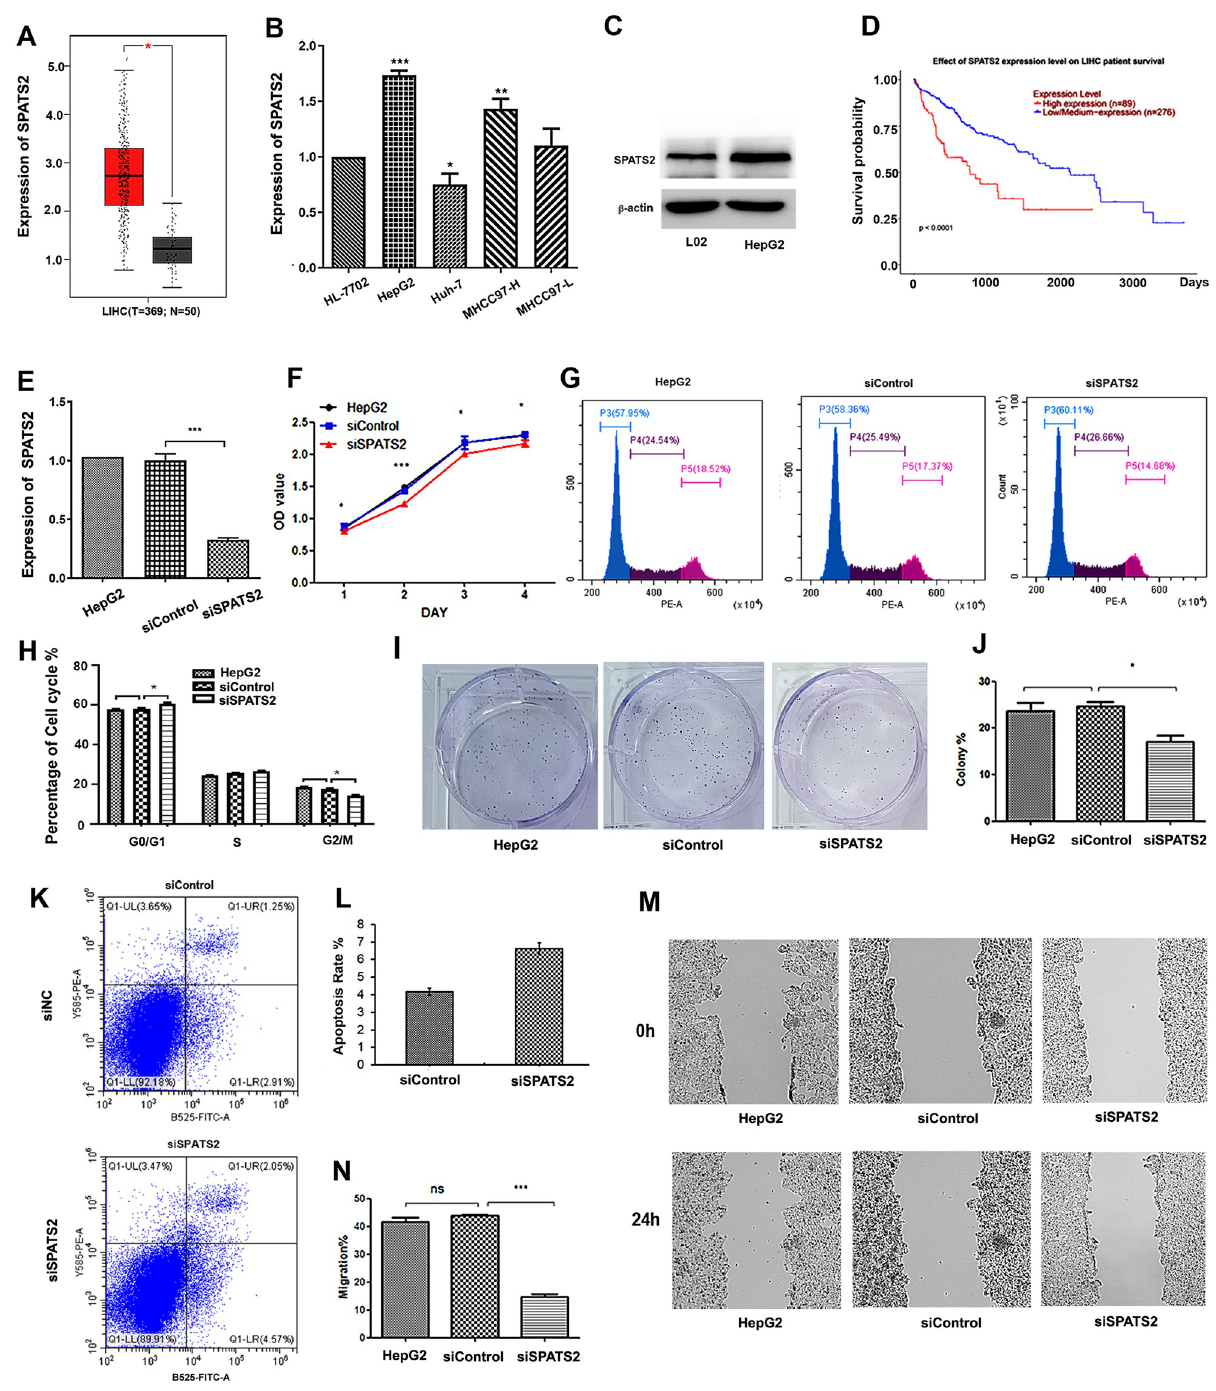
Fig 1. Knockdown of SPATS2 inhibits the malignant phenotypes of HepG2 cells. (A) Expression of SPATS2 in HCC tissues and adjacent normal liver tissues. (B) mRNA levels of SPATS2 in different HCC cell lines. (C) Protein levels of SPATS2 in HepG2 and normal cells. (D) Survival curves were analyzed by Kaplan-Meier survival analysis. (E) Expression of SPATS2 in siSPATS2-transfected HepG2 cells (F) MTT assays detected that the proliferation of SPATS2 downregulated HepG2 cells. (G, H) FACS analysis showed that downregulation of SPATS2 represses the cell cycle in HepG2 cells. (I, J) SPATS2 knockdown induced a decrease in the clonogenic survival ability of HepG2 cells. (K, L) FACS analysis showed that downregulation of SPATS2 induces apoptosis of HepG2 cells. (M, N) Wound healing assays in siSPATS2 HCC cells. The experiment was repeated three times, and a representative blot image is shown. � p < 0.05, �� p < 0.01, ��� p < 0.01.